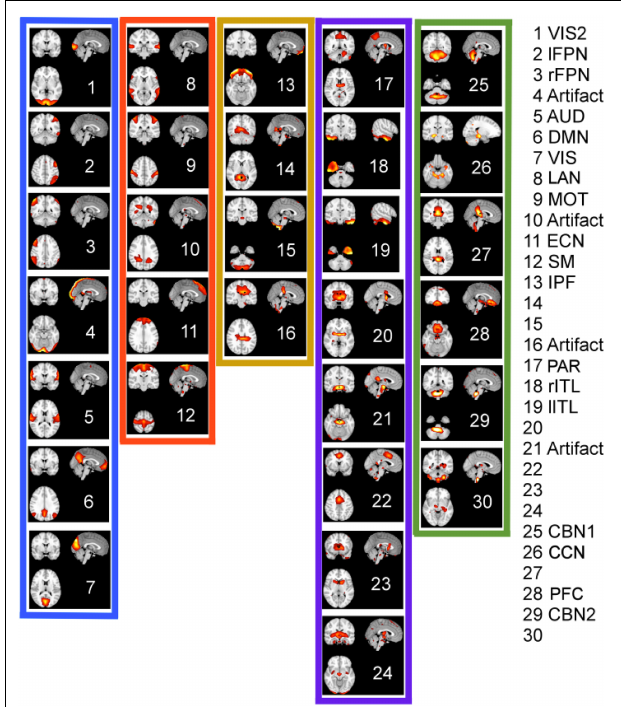
FIGURE 10 | Ordered ICA components according to K-means clustering of the energy-period relationships of IMFs using EMD. The color-framed ICA components correspond to the five major clusters in Figures 8 , 9C for the EMD method. The numbering of the ICA components from 1 to 30 was chosen by ordering the ICA components according to the value of the 1st PCA component of Figure 9C (from largest value to smallest value). Identified networks are listed on the right; a blank entry indicates that the network is unknown (to us) or has not been studied. Some of the unknown networks may be due to artifacts. Anatomical regions are listed for each network in Supplementary Material 2 . Low frequency networks most studied in recent literature belong to clusters 1 and